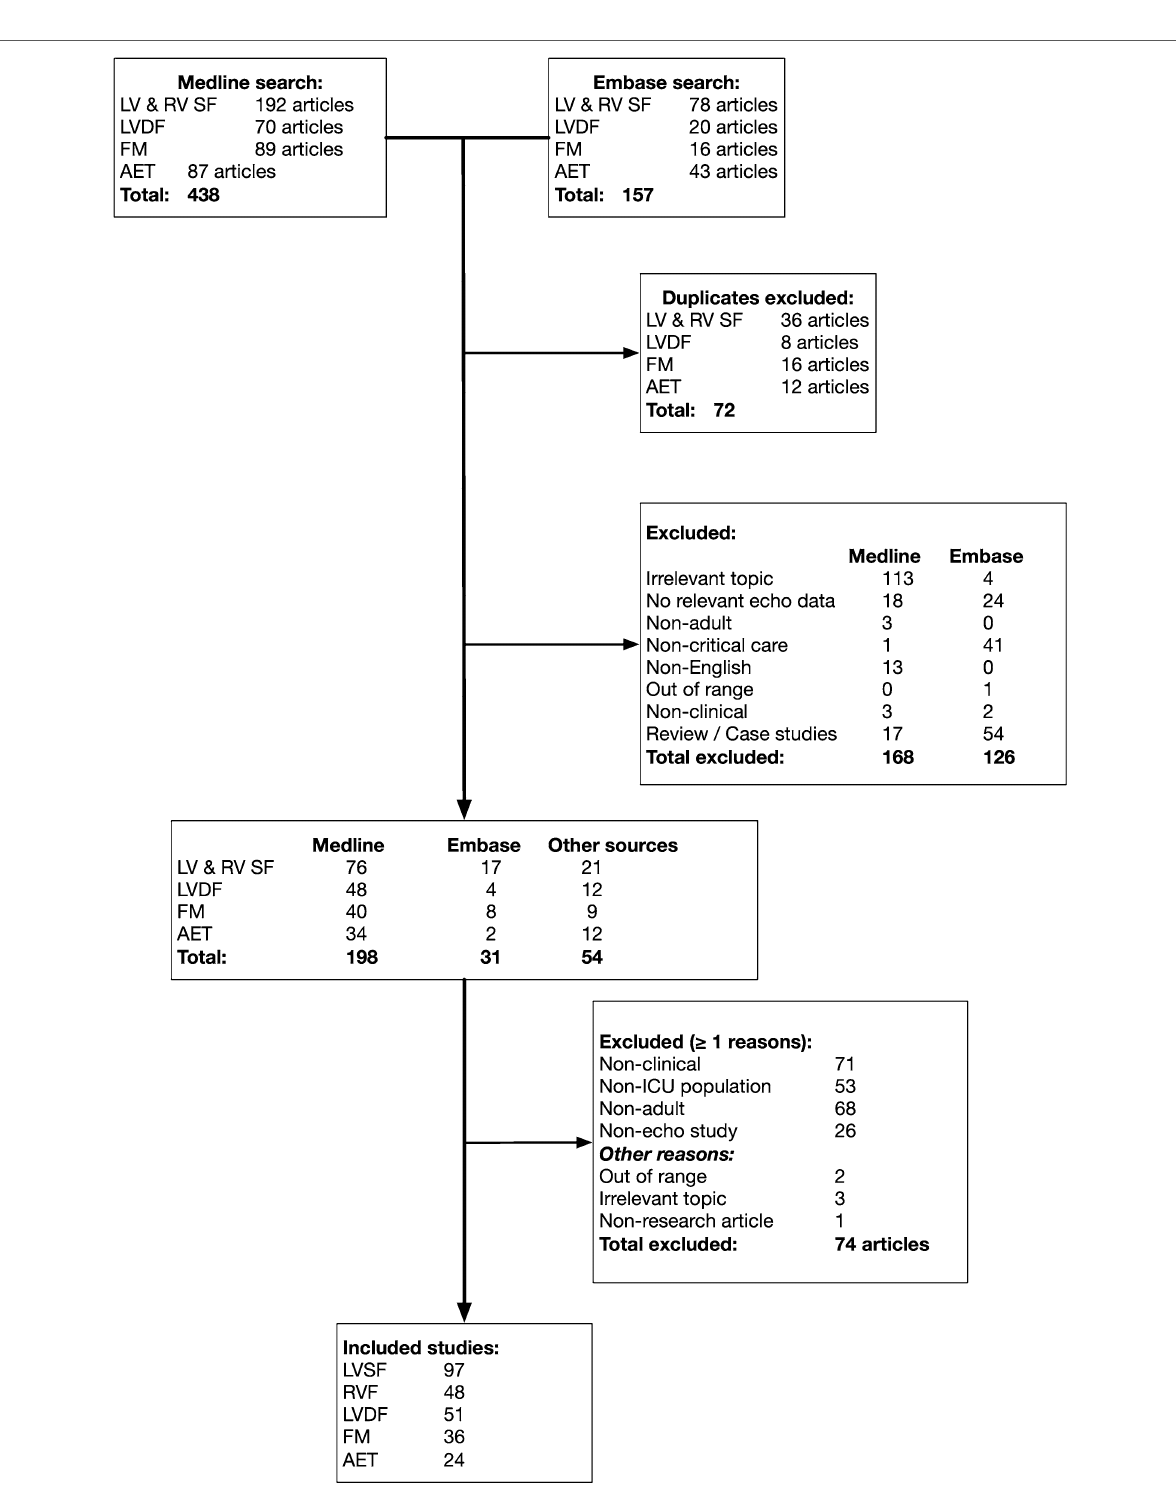
Fig. 1 Flowchart of the literature search. AET advanced echocardiography techniques, FM fluid management, LVDF left ventricular diastolic function, LVSF left ventricular systolic function, RVF right ventricular